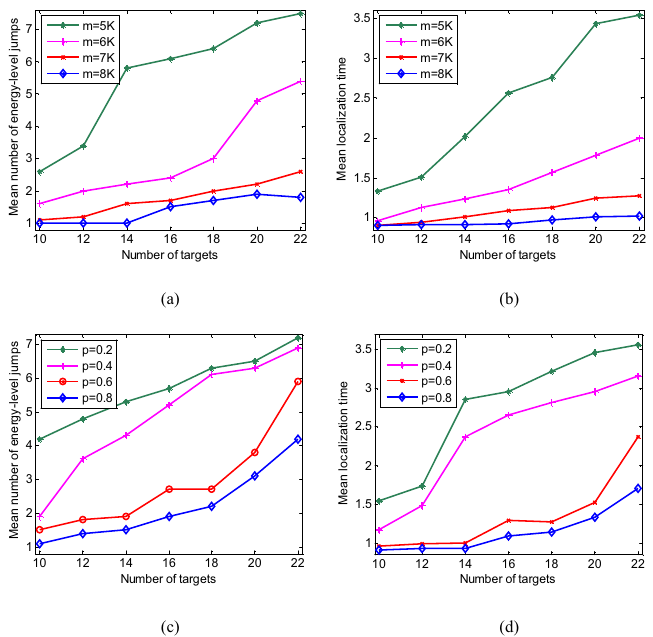
Figure 8. Performance analysis of ELJ for different K , m and p . ( a ) Comparison of the mean number of energy-level jumps for the different number of targets when p = 0.5. ( b ) Comparison of the mean localization time for the different number of targets when p = 0.5. ( c ) Comparison of the mean number of energy-level jumps for the different p when m = 6 K . ( d ) Comparison of the mean localization time for different p when m = 6 K